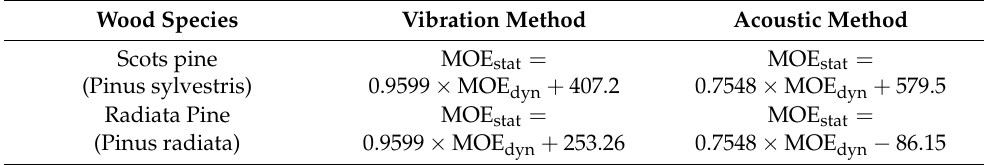
Table 3. Formulas for converting MOE dyn [MPa] to MOE stat [MPa] [53].